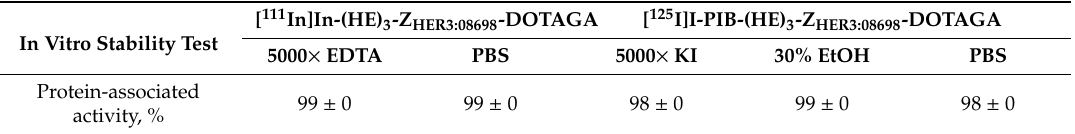
Table 1. In vitro stability of [ 125 I]I-PIB-(HE) 3 -Z HER3:08698 -DOTAGA and [ 111 In]In-(HE) 3 -Z HER3:08698 - DOTAGA. Radioiodinated a ffi body molecule was incubated for 4 h with 5000-fold molar excess of KI in PBS or with 30% ethanol and compared to PBS control. Indium-labeled a ffi body molecule was incubated with 5000-fold molar excess of EDTA. Analysis was performed in duplicates. In Vitro Stability